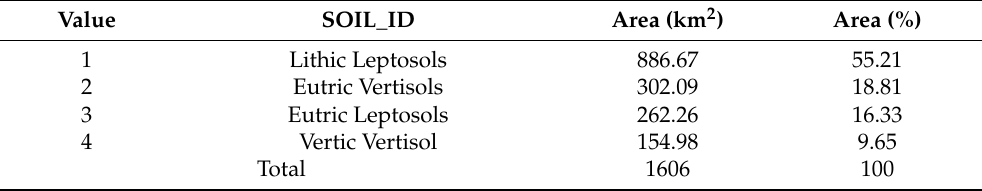
Table 2. Major soil types in Borkena Catchment (source: Ministry of Water and Energy (MoWE)).